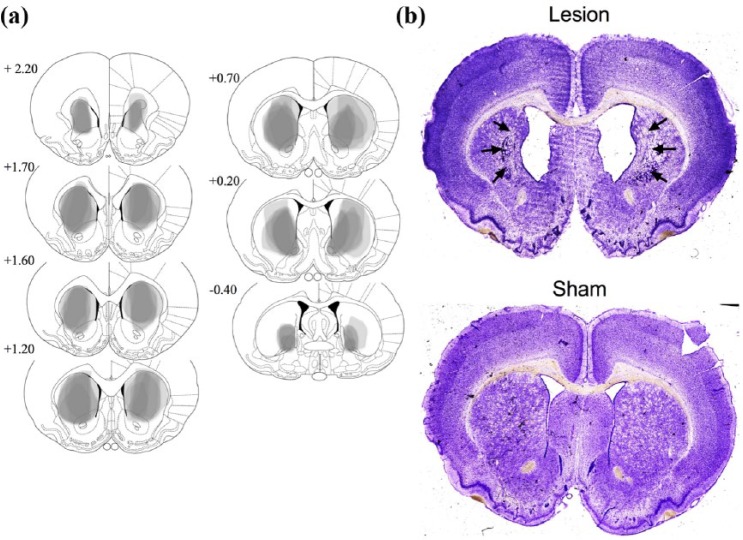
Histological analysis of DStr lesions: (a) schematic diagrams of DStr
lesions. Grey scale shading indicates extent of neuronal loss across
subjects, with each subject represented as a separate stacked layer.
Diagrams are modified from Paxinos and Watson (2005)
and (b) photomicrographs of cresyl-stained coronal sections,
depicting typical lesions of DStr-lesioned (top) and sham-lesioned
(bottom) rats. Arrows indicate the site of lesion.